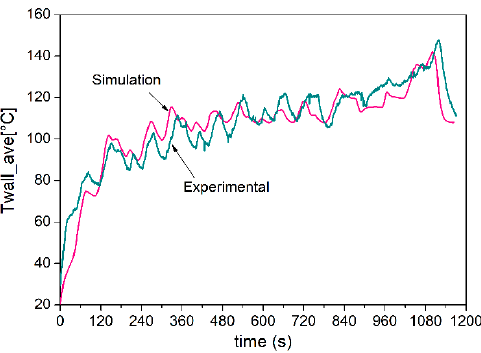
Figure 7. The average metal temperature during the New European Driving Cycle (NEDC); comparison between numerical simulations and experimental tests (the temperature at position 11C of Figure 5).